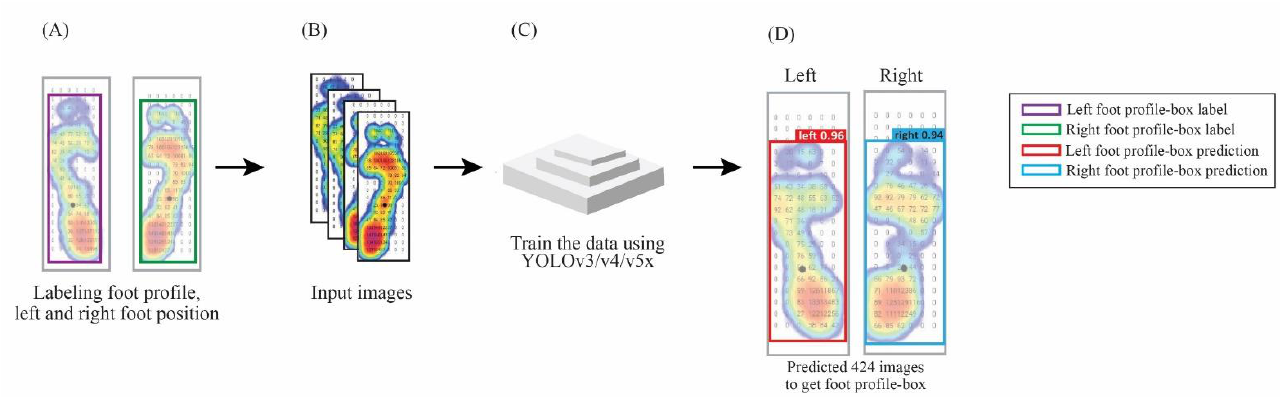
(Figure 2D). A foot profile-box was used to determine the left foot or right foot position since detecting the foot profiles essential for the differentiation direction of the FPA.